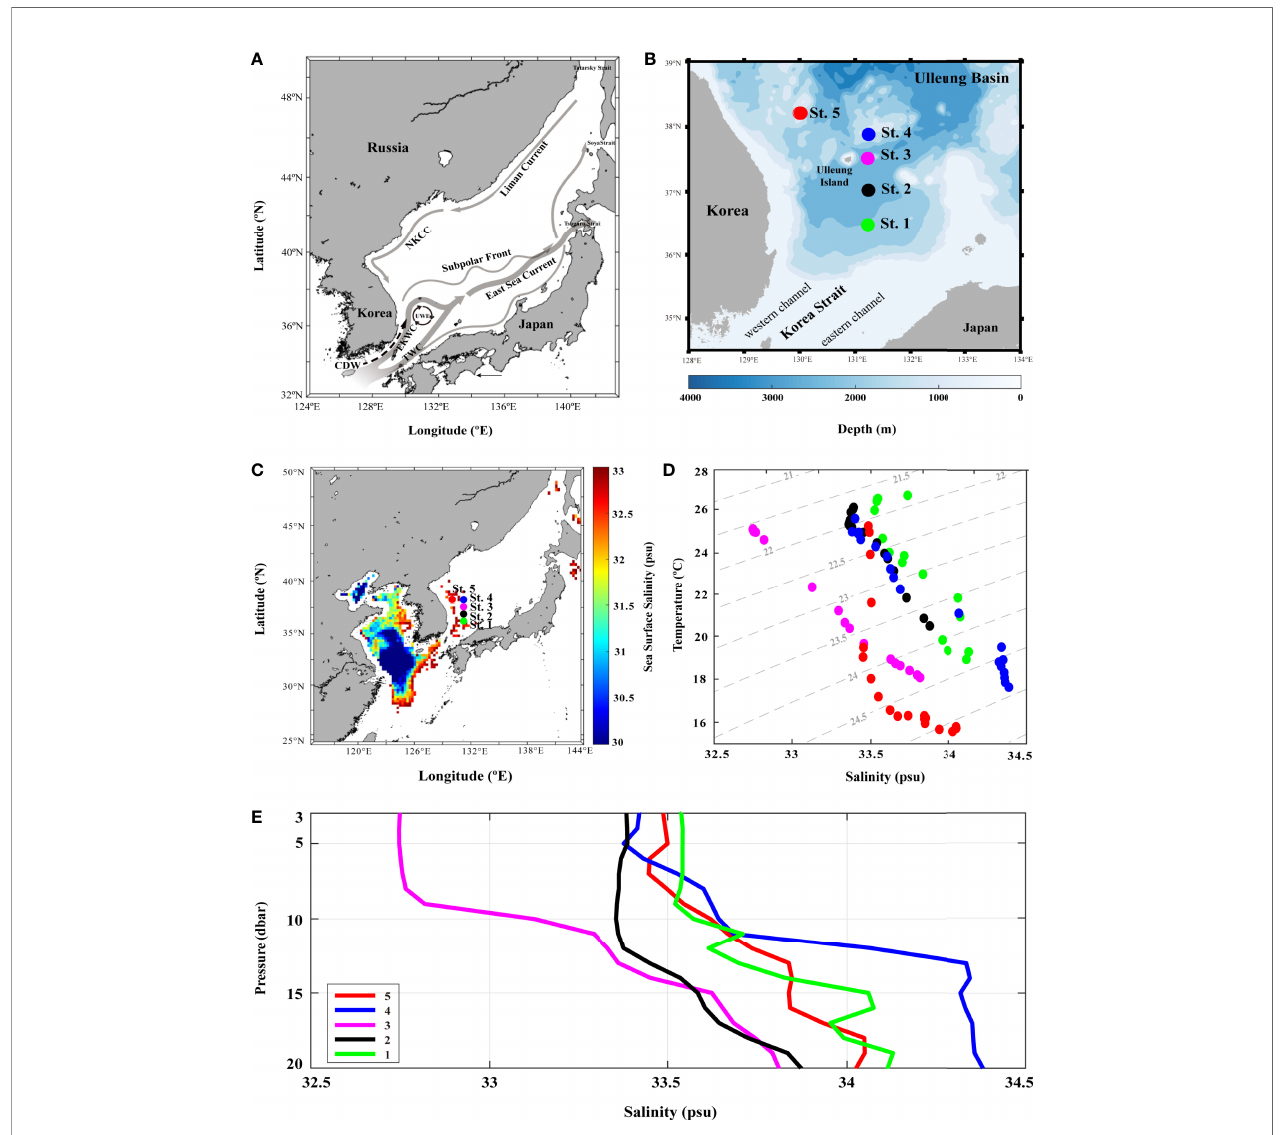
FIGURE 1 | The surface currents identi fi ed in the East Sea and fi ve sampling stations in Ulleung Basin (UB). (A) map with arrows represent major surface currents and gyre identi fi ed in the East Sea: Changjiang diluted water (CDW) fl ows from Changjiang river in summer, Tsushima warm current (TWC) enters into the East Sea through Korea strait (KS), and East Korean warm current (EKWC) fl ows along the eastern coast of Korea and enters UB. Subpolar front (~40°N) divides the East Sea into two regions, southern large eddy kinetic energy region and northern with small eddy kinetic energy region. East Sea current is a broad current that EKWC and Eastern Branch form after leaving the respective coasts of Korea and Japan. North Korea cold current (NKCC) is a year-round mean current along the coast of North Korea. Liman Current (LC), which fl ows southward along the Siberian coast down to Vladivostok. Ulleung warm eddy (UWE), originating from EKWC, northward branch of the warm and saline TWC, is a well-known physical phenomenon in the center of the southwest East Sea; (B) map of the fi ve sampling stations in UB using Tamgu 3 during August and December, 2019; (C) sea surface salinity gridding map using August (summer) monthly data from Ocean Color; (D) temperature – salinity diagram of 0 – 20-m depth seawaters at the fi ve stations; and (E) vertical distribution of salinity in 0 – 20 dbr pressure measured with CTD at each